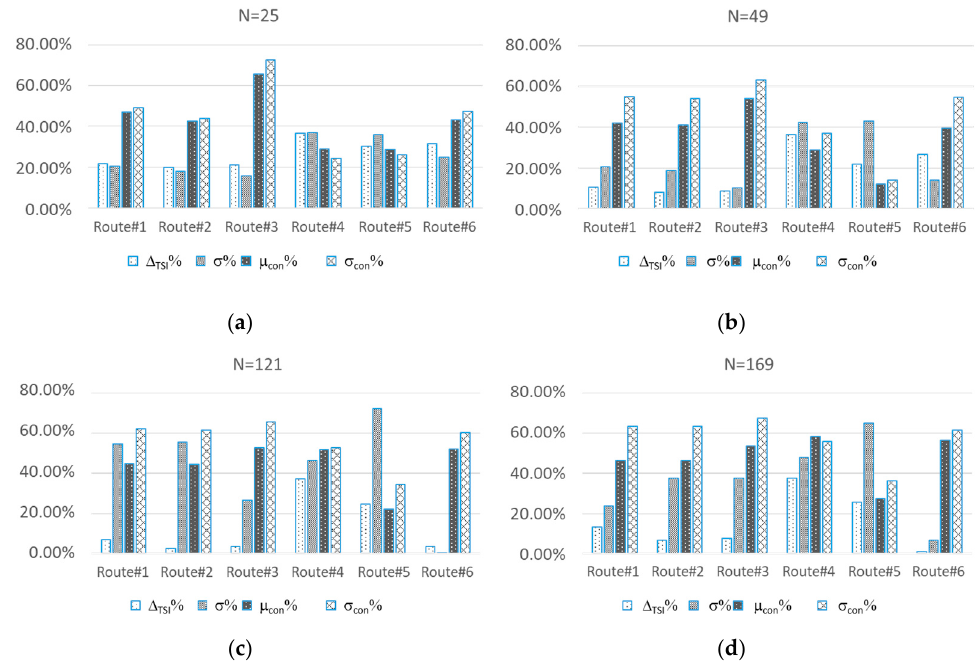
Figure 3. Percentage improvement of ∆ TIS and σ and percentage variation of μ con% and σ con% , with respect to the case of static topology.